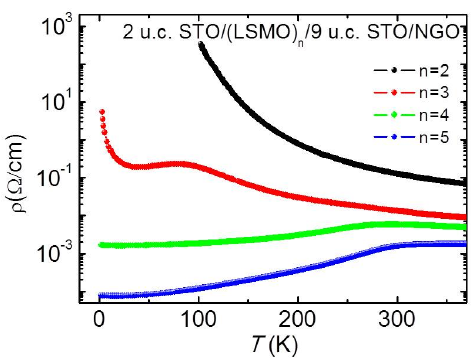
Figure 5. Temperature dependent resistivity of different thicknesses of STO-sandwiched LSMO layers grown on NdGaO 3 (110) substrate. Figure is adapted from Ref. [39].